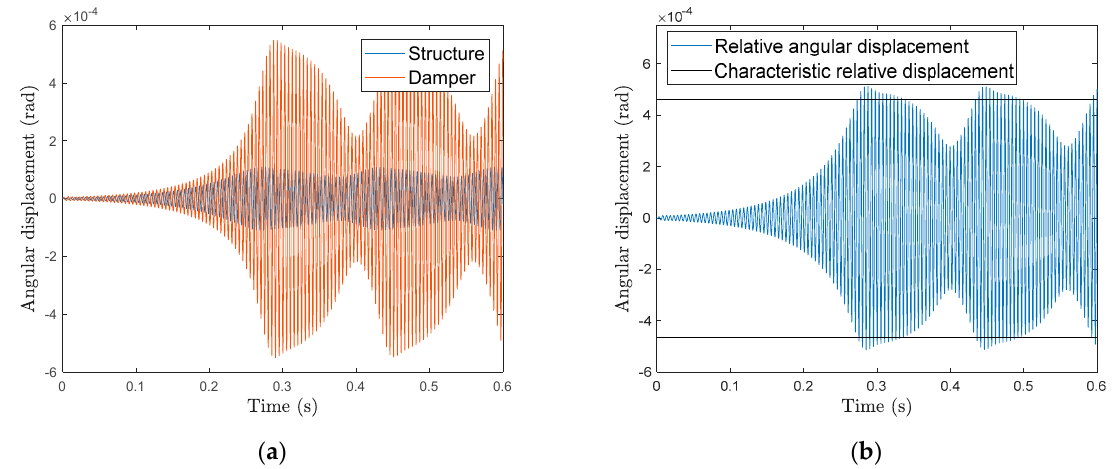
Figure 11. Time domain results for an instability of D i = − 1.6%. ( a ) Angular displacement of the drill string structure and the damper. ( b ) Relative angular displacement between the damper and the drill string structure.